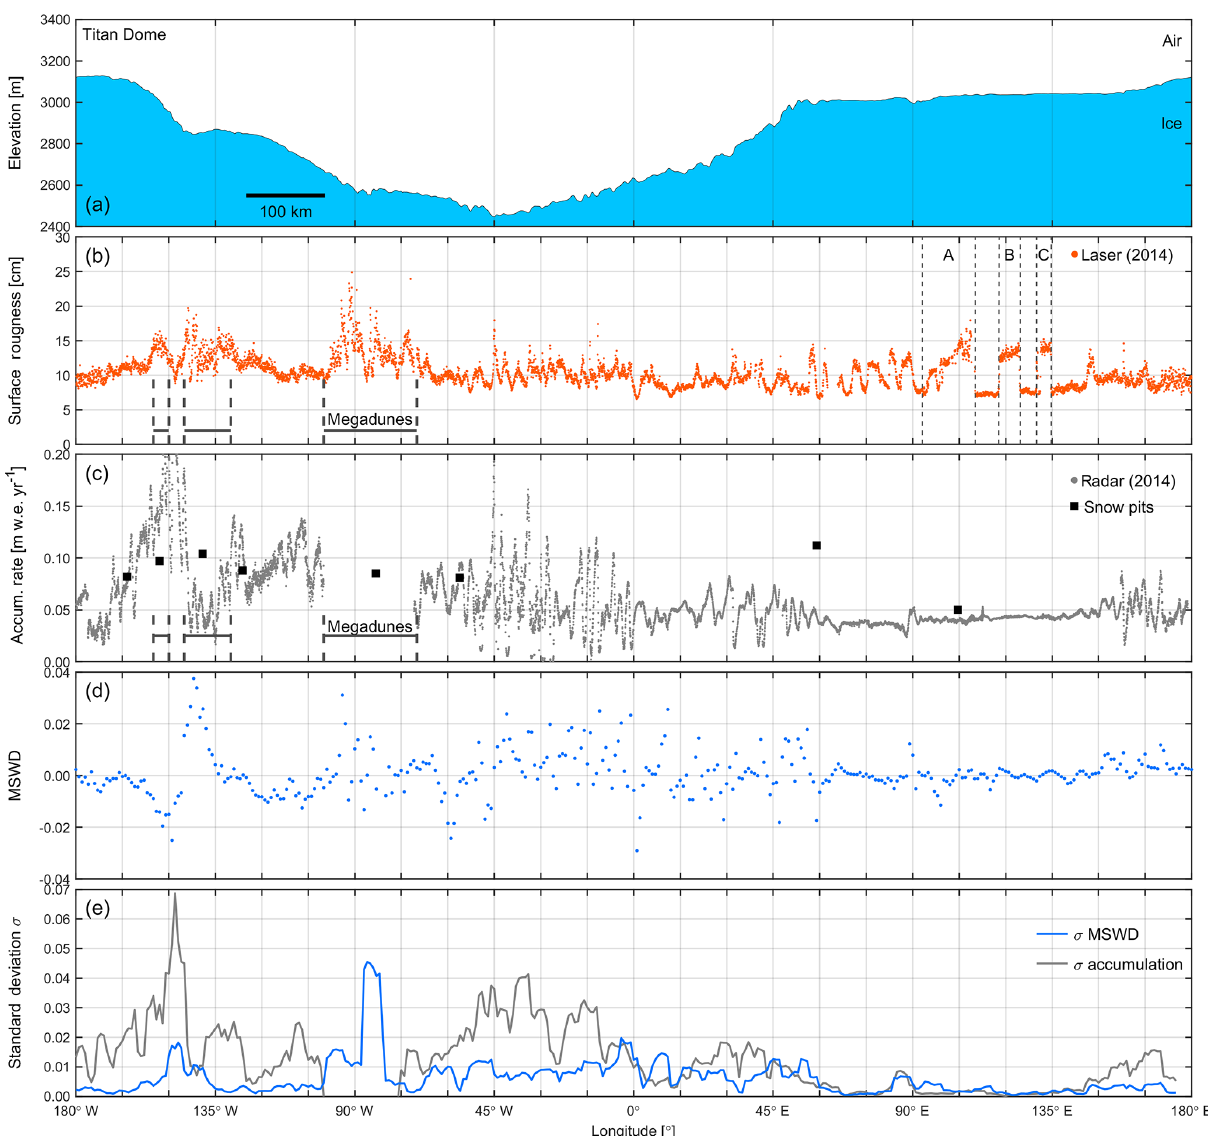
Figure 6. (a) Ice surface elevation around 88 ◦ S from ATM laser altimetry. (b) Surface roughness from ATM laser altimetry. (c) Snow accumulation rate derived from 2014 snow radar data and tied to MERRA-2. A 14min disk failure of the snow and Ku-band radars in 2014 resulted in a data gap over the megadunes and therefore the accumulation rate. Squares indicate accumulation measurements from snow pit data within 10km of 88 ◦ S (Favier et al., 2013; Taylor, 1971). (d) Mean slope in the mean wind direction (MSWD) in 1 ◦ longitude bins (4km). (e) Standard deviation σ of the MSWD and snow accumulation rate estimated over 20km long